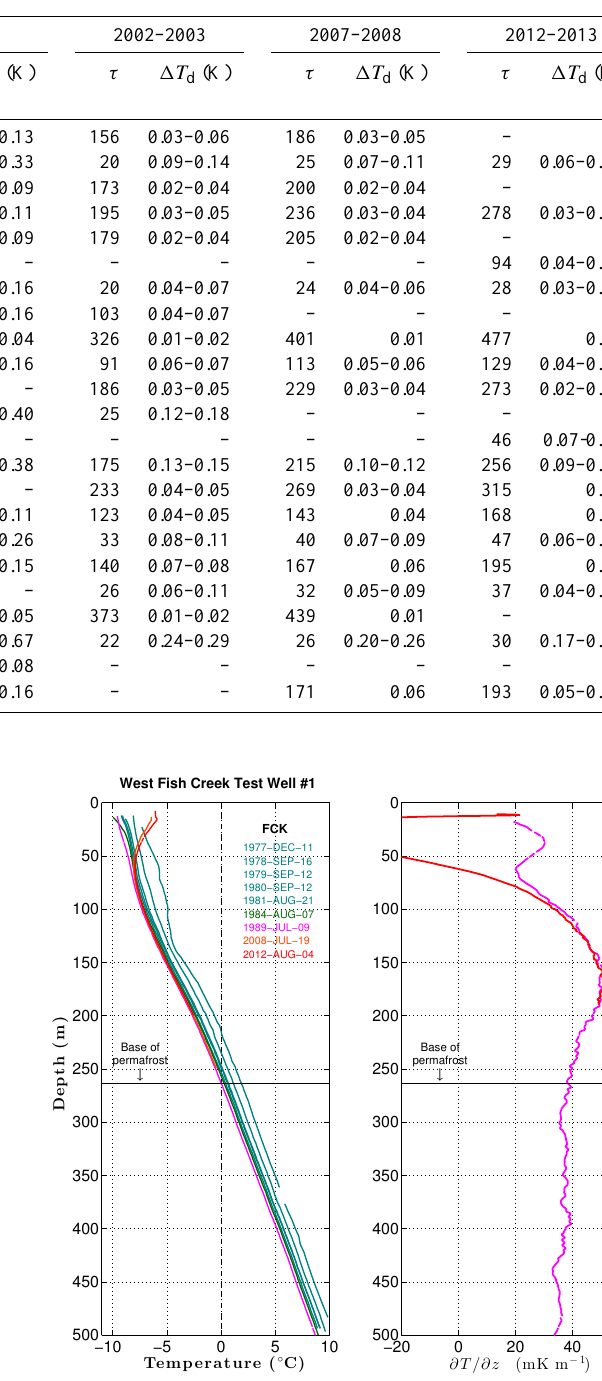
Table 2. Drilling disturbance 1T d remaining in the DOI/GTN-P monitoring wells at the time of the 1989, 2002–2003, 2007–2008, and 2012–2013 field campaigns. The corresponding dimensionless times τ are also listed.